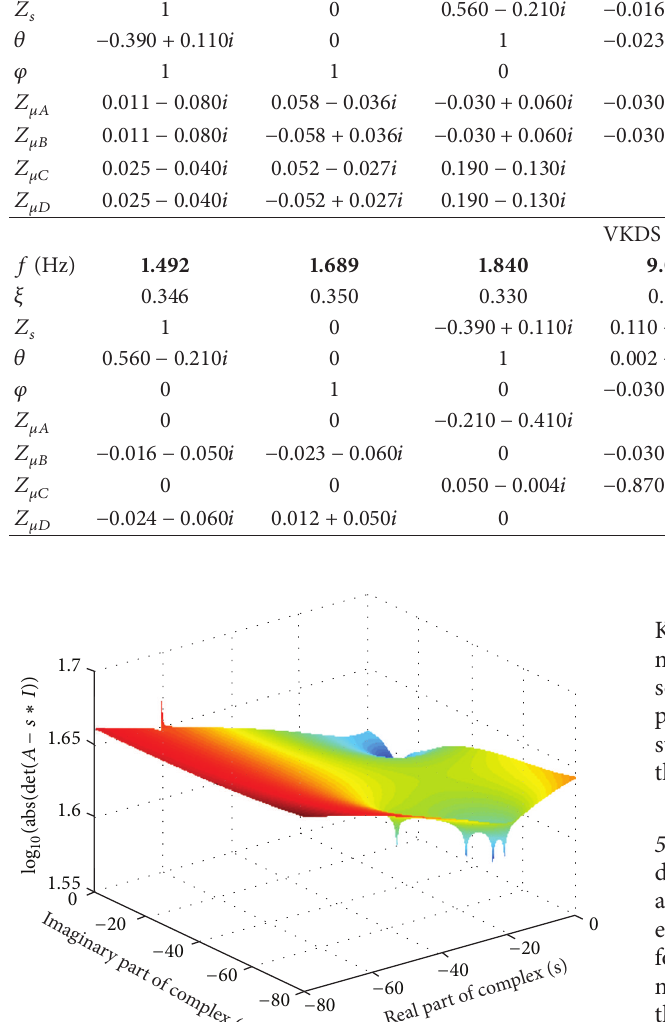
(from 1.528 Hz to 1.689 Hz) and maintain the bounce and pitch modes (the 1st and 3rd modes) frequencies of the sprung mass vibration (from 1.493 and 1.842 Hz to 1.492 and 1.840 Hz). Furthermore, it can reduce the natural frequencies of the warp and oppositional hops between the left and right wheels (from 10.552 and 10.110 Hz to 9.040 and 9.930 Hz) and hold the natural frequencies of oppositional and synchronous hops between the front and rear wheels (from 9.837 and 10.211 Hz to 9.840 and 10.210 Hz). The KDS system can simultaneously increase the damping ratios corresponding to the roll and warp modes of the integrated